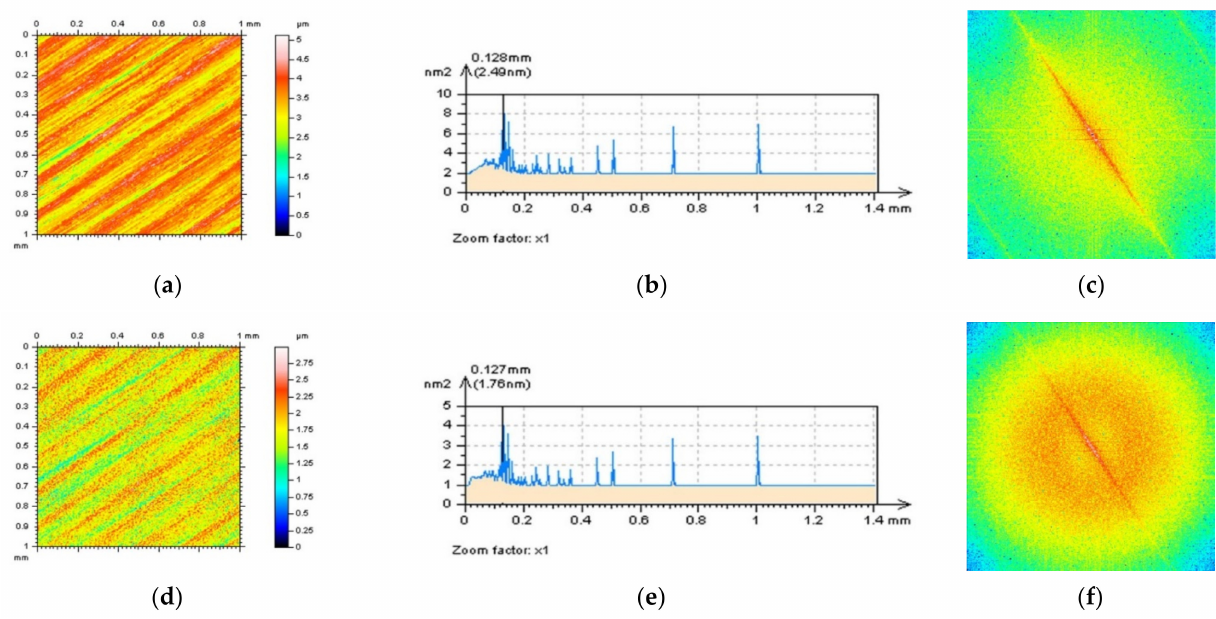
Figure 1. Countour map plots ( a , d ), PSDs ( b , e ) and FSs ( c , f ) were received for optical measurement of milled surface, surface M1(1) without a noise (upper raw) and surface M1(2) containing a high- frequency measurement error (down